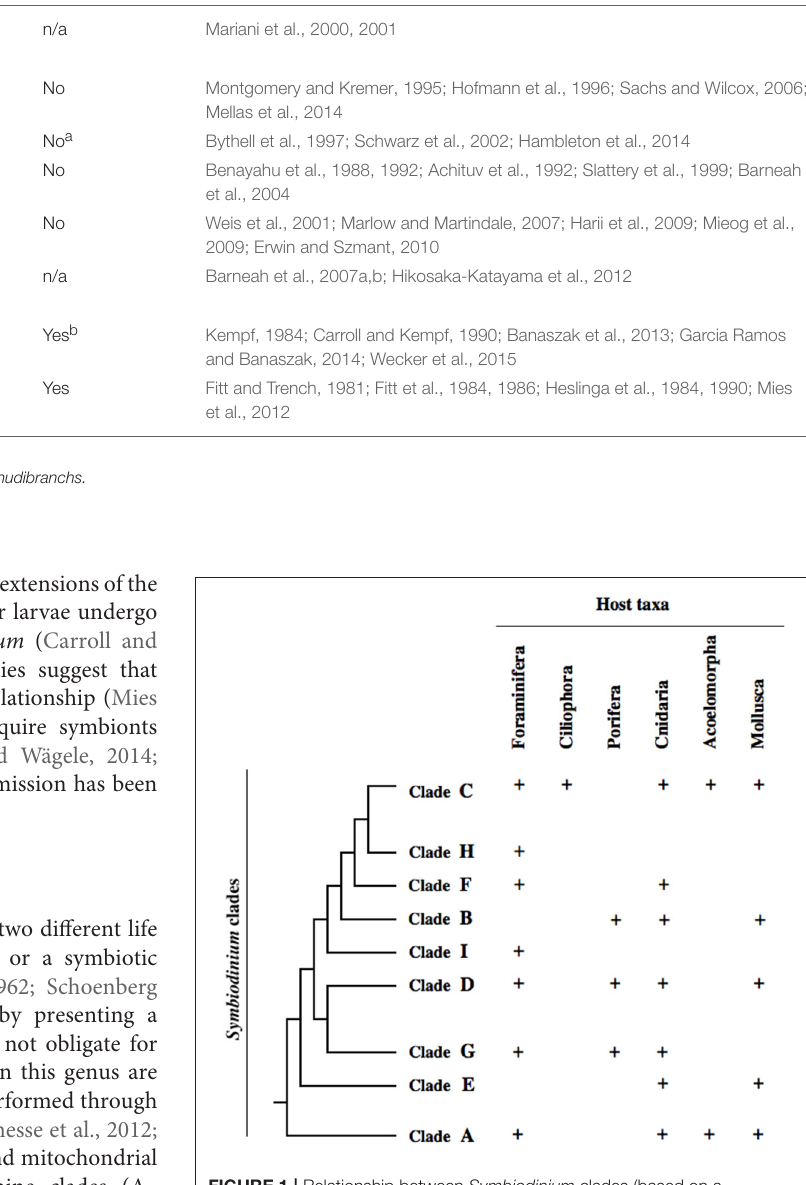
result, many new taxa and/or strains have been described recently (LaJeunesse et al., 2012; Hume et al., 2015; Lee et al., 2015; being present in the genus Symbiodinium (LaJeunesse,